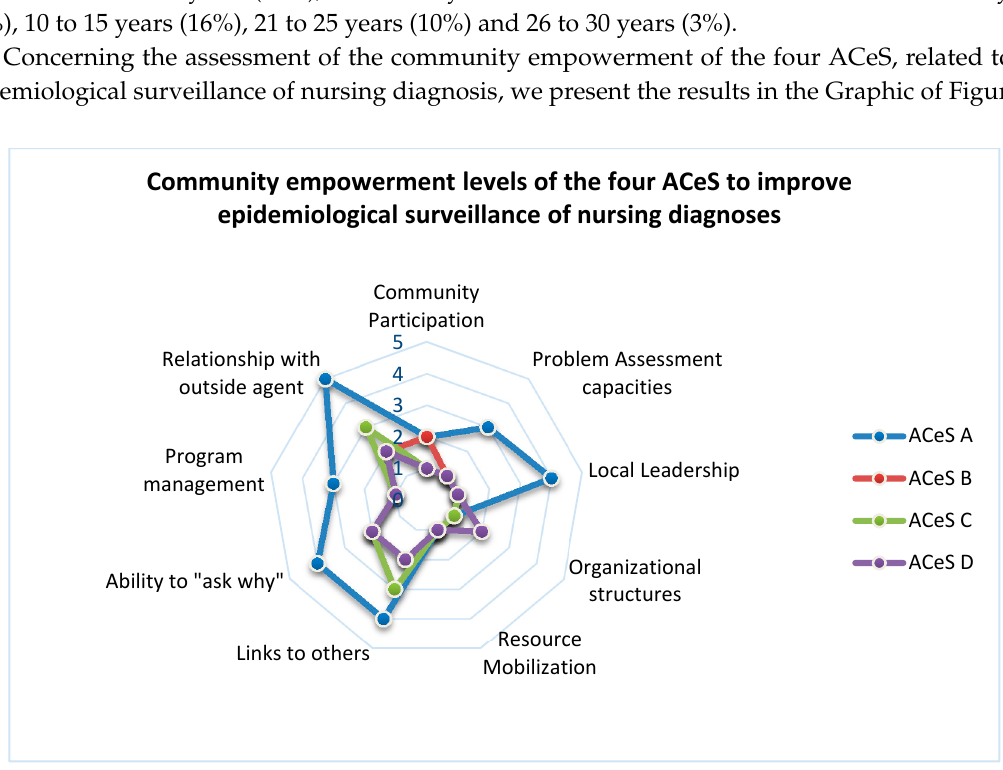
Figure 2 Level of community empowerment of the four ACeS to promote epidemiological Figure 2. Level of community empowerment of the four ACeS to promote epidemiological surveillance surveillance of nursing diagnoses. of nursing